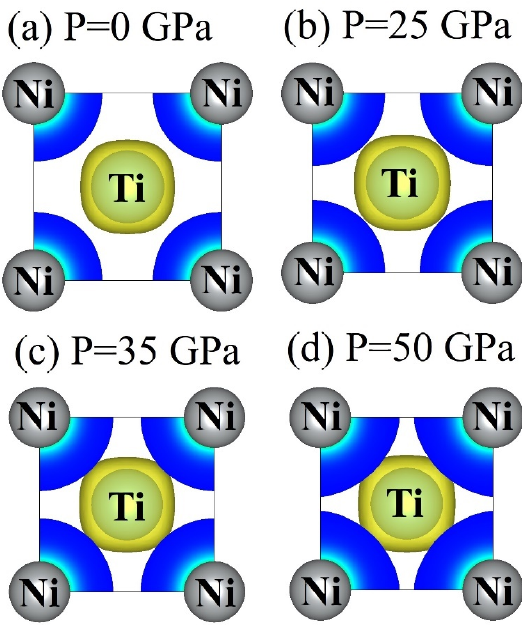
Figure 12. Schematic of isosurface contours of charge density for the NiTi SMA under different pressures; the isosurface levels are set as 0.045 r − 3